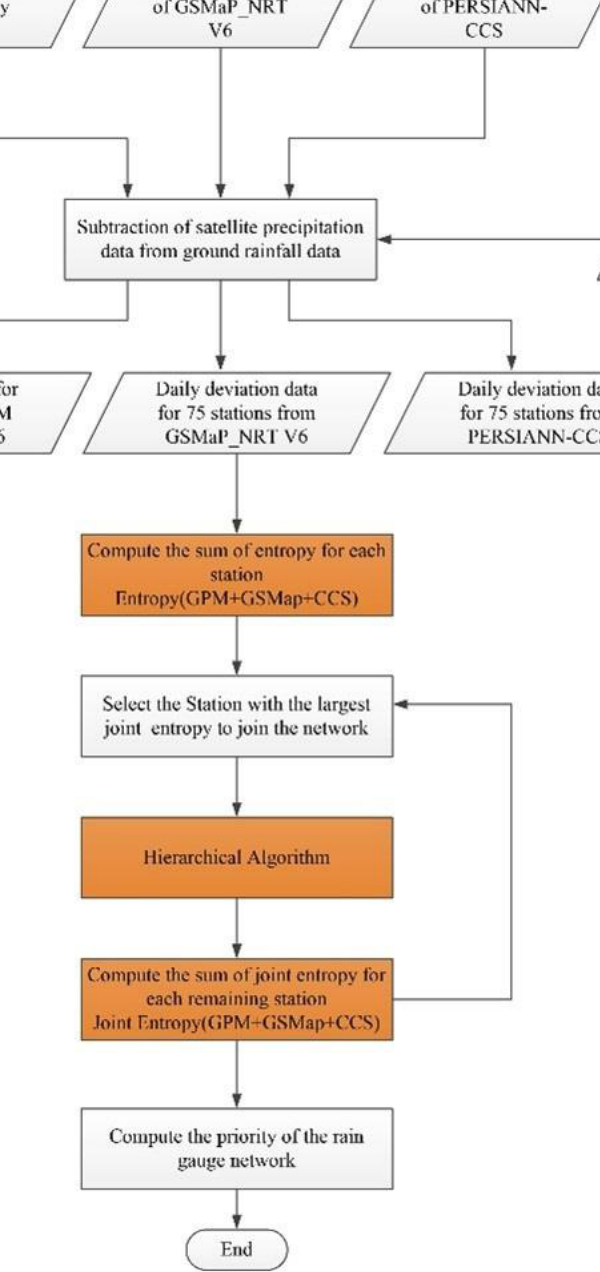
Figure 1. Flow chart of rain gauge station network